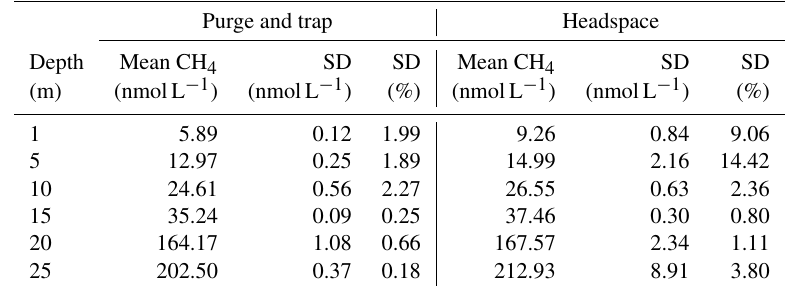
Table 1. Boknis Eck April 2020 concentrations and deviations measured with PT and HS.